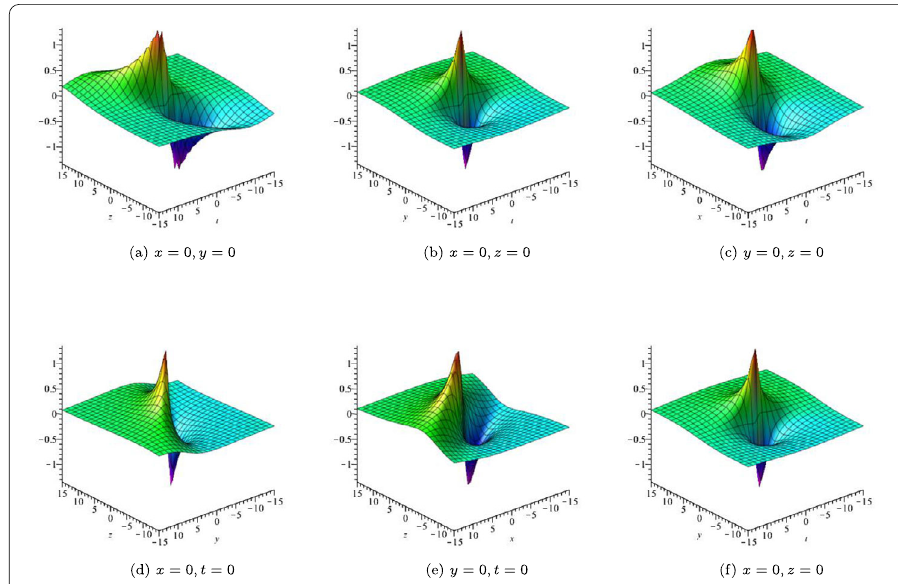
Figure 8 The lump solutions for Eq. (1.2) in different planes with parameters a 1 = 2, b 1 = 0, a 2 = b 2 =